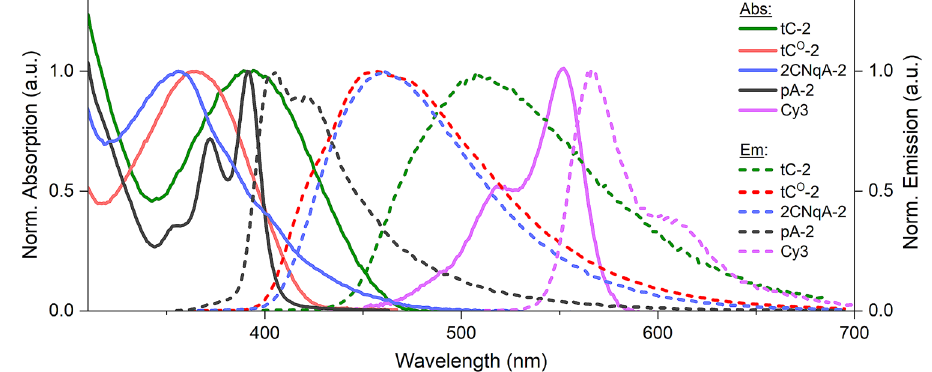
Figure 3. Normalized UV–vis absorption spectra (solid lines) and emission spectra (dashed lines) of the tC-2 (green), tC O -2 (red), 2CNqA-2 (blue), pA-2 (black), and Cy3 (violet) gapmers.